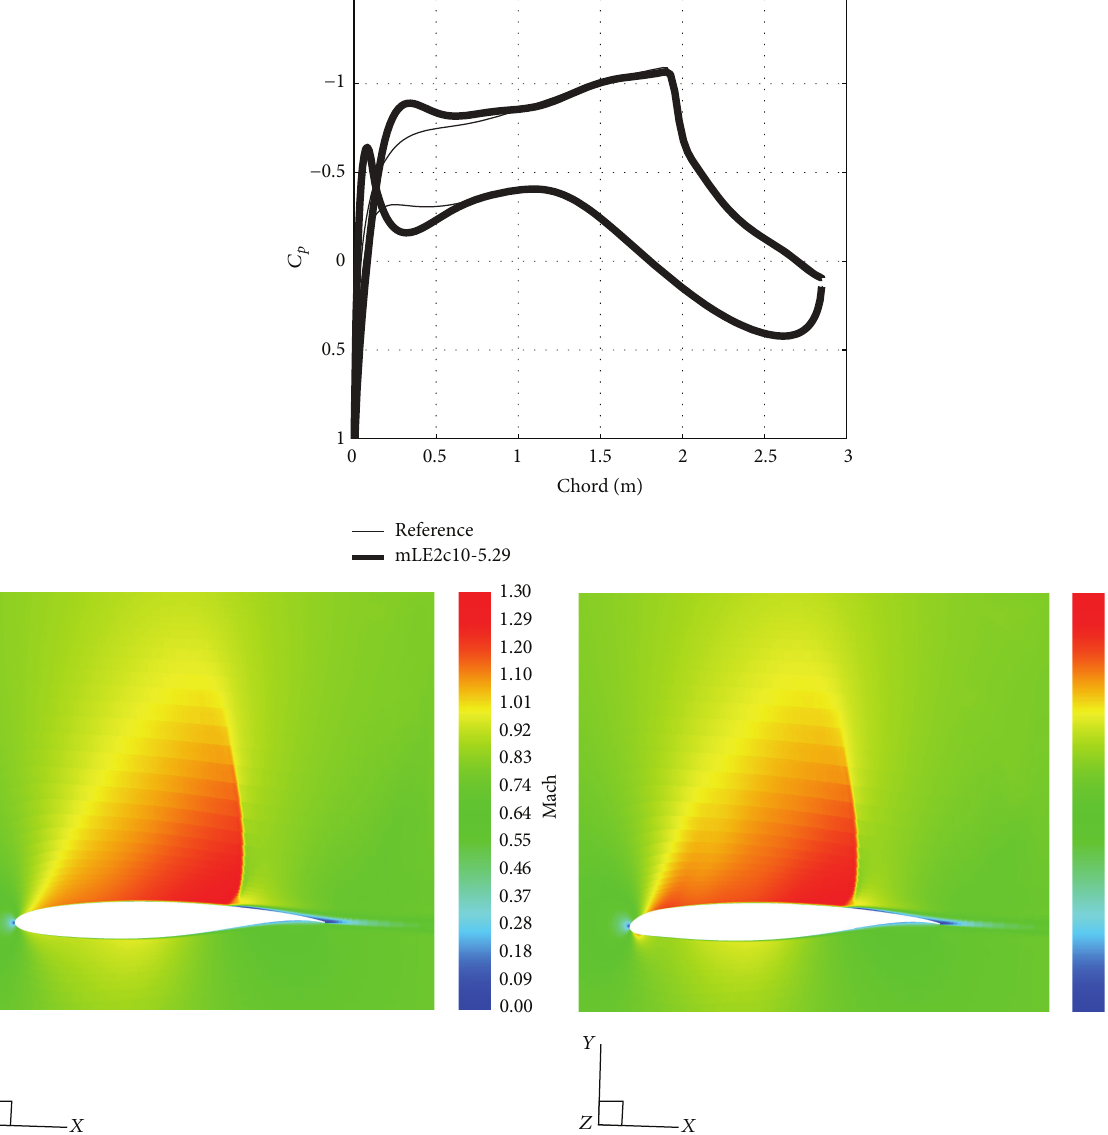
Figure 12: Morphing leading edge in high speed conditions: comparison between reference and deformed shape 2D results in terms of 𝐶 𝑝 and Mach chordwise